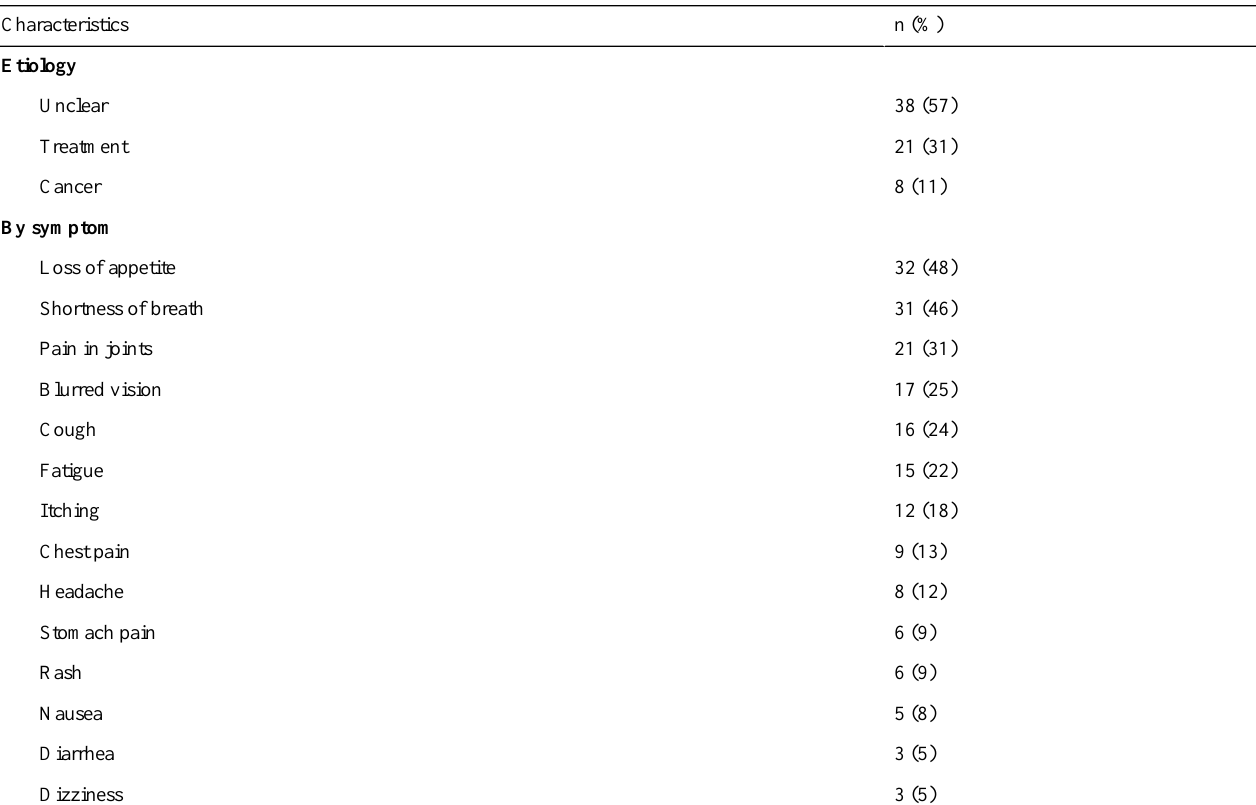
Table 4. Etiology of the symptom questionnaire alerts